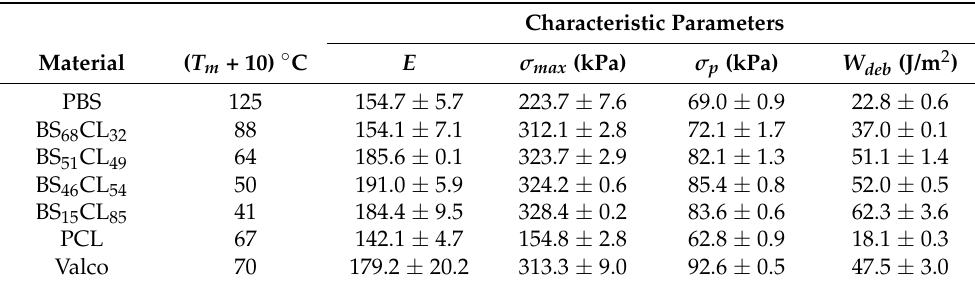
Figure 7. Stress-strain curves at different compositions obtained from probe-tack experiments and the same relative temperature with respect to T m (T m + 10). The inset graph represents the effect of debonding velocity for BS 15 CL 85 copolyester obtained a 41 °C. In all cases, fibrillation was observed. Table 2. Tack characteristic parameters obtained from the stress–strain curves at ( T m + 10 ) and a V deb of 0.314